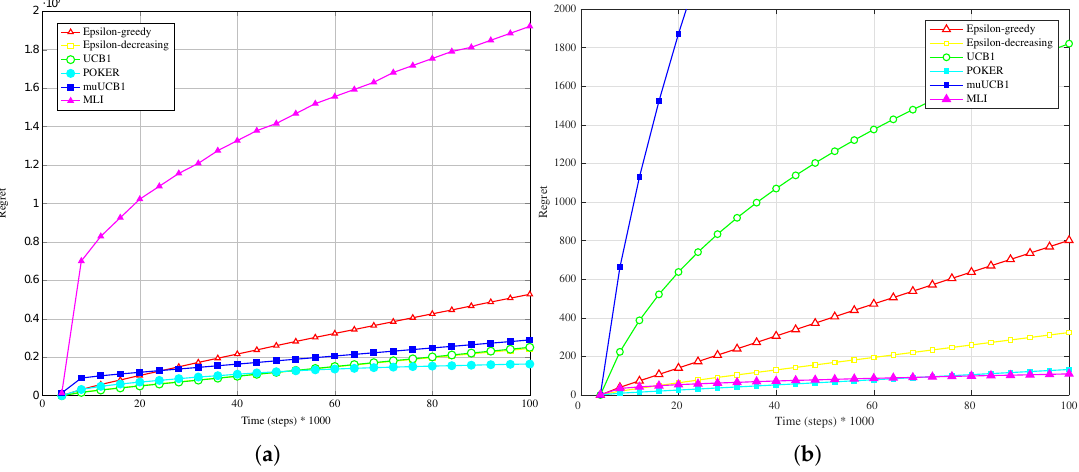
Figure 12. Performance in terms of regret of the six considered algorithms, with real captured data used as reward and T U / T M = 5. ( a ) linear conversion; ( b ) logarithmic